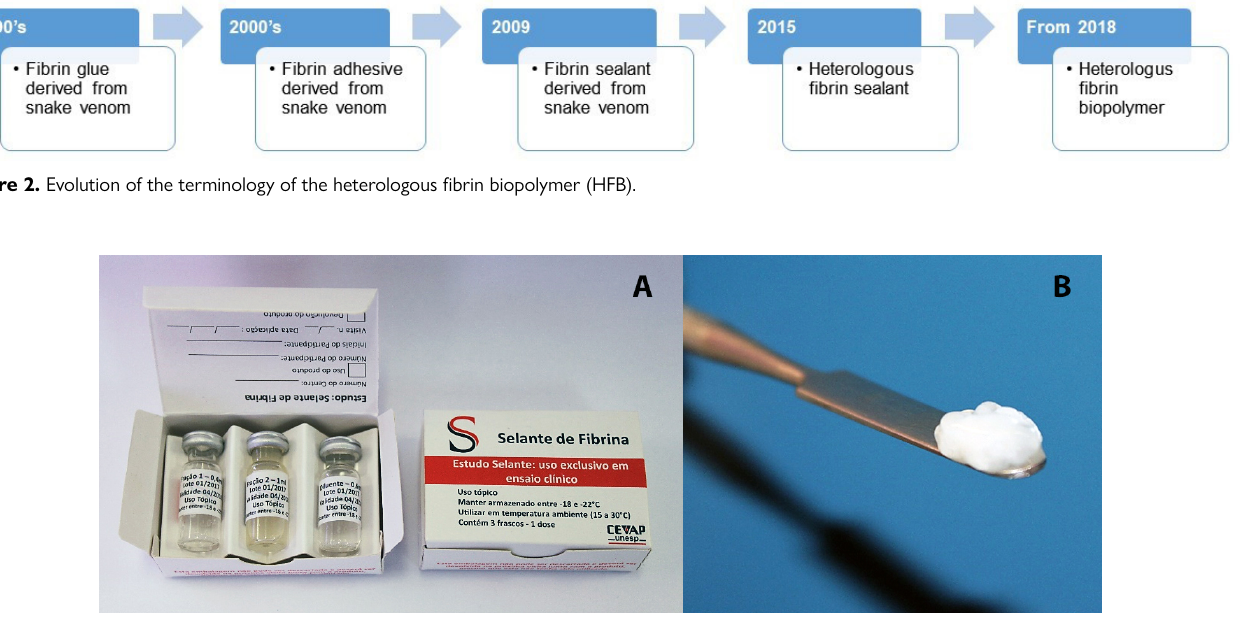
Figure 3. The heterologous fibrin sealant (HFS) produced by CEVAP. (A) Fractions, (B) stable clot formed after mixture of the components.